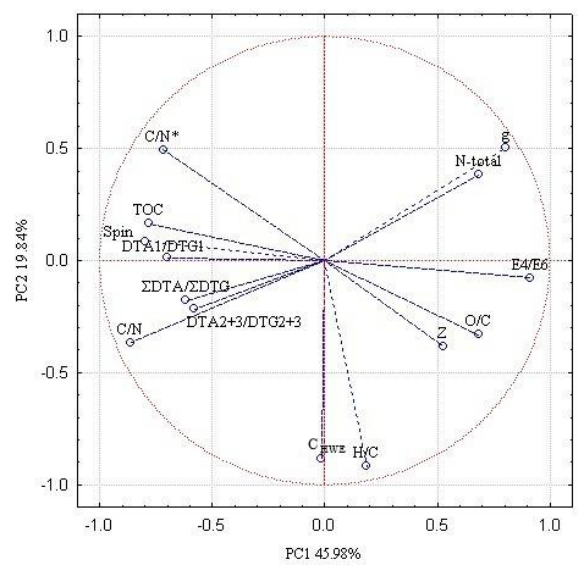
Figure 5. Eigenvectors of soil chemical variables: Abbreviations as in the Tables 1–9. Table 10. Analysis of principal components for Baltic-type raised bog, fen, and peat-moorsh soils. Principal Components Eigenvalues % of total